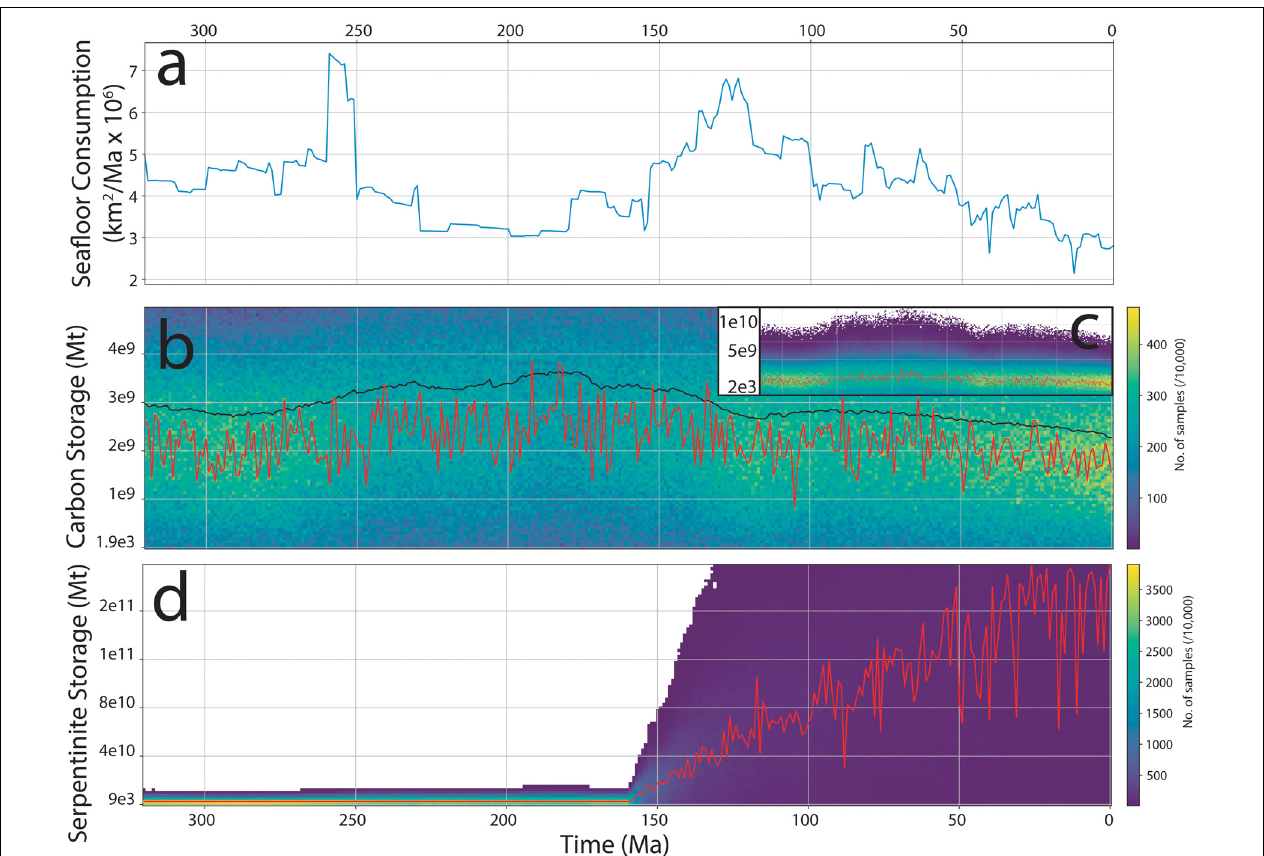
FIGURE 12 | (A) Seafloor consumption rates from Matthews et al. (2016) (using PMSR). (B) Binned distribution of total sequestered carbon in ocean basins (black line is the mean, red line is the mode) using POSR. (C) Full distribution of (B) . (D) Binned distribution of total serpentinite in ocean basins (red line is the mode) using POSR. Due to the interpolation and gridding of our data, together with inconsistencies in the plate model, our measure of total storage slightly over-estimates the actual result and is to be interpreted as a maximum. See Supplementary Material 1 , 2 for table of results and Supplementary Material 3 , 5 for grids in 1 Ma